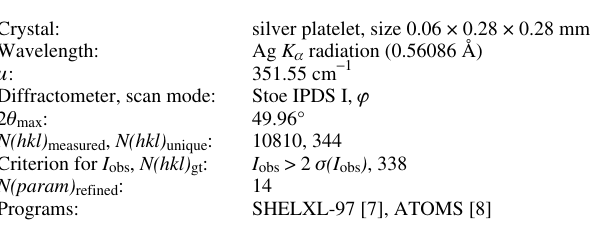
Table 1. Data collection and handling.